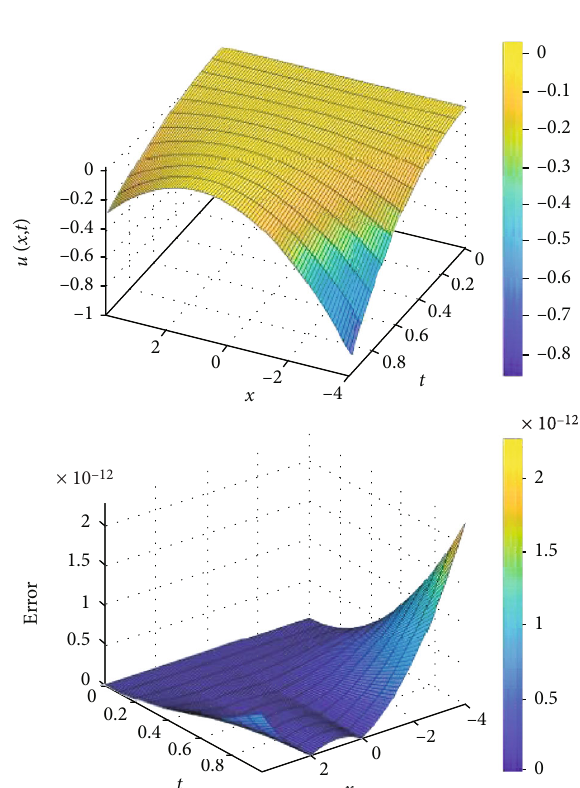
Figure 3: Portrait of the numerical solution and the absolute error for Example 8 with m = 4, n = 10